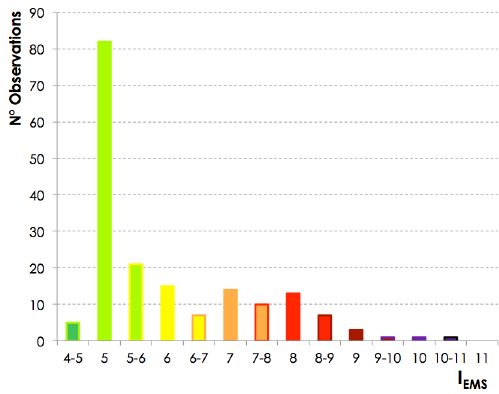
Figure 2: I macroseismic data EMS